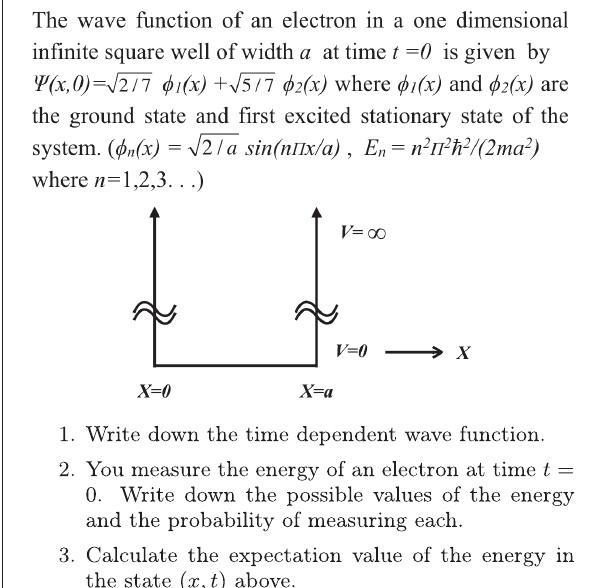
FIG. 6. Calculate the expectation value of the energy in the state ψ ð x; t Þ . On this problem, student difficulties display content error. Figure originally from